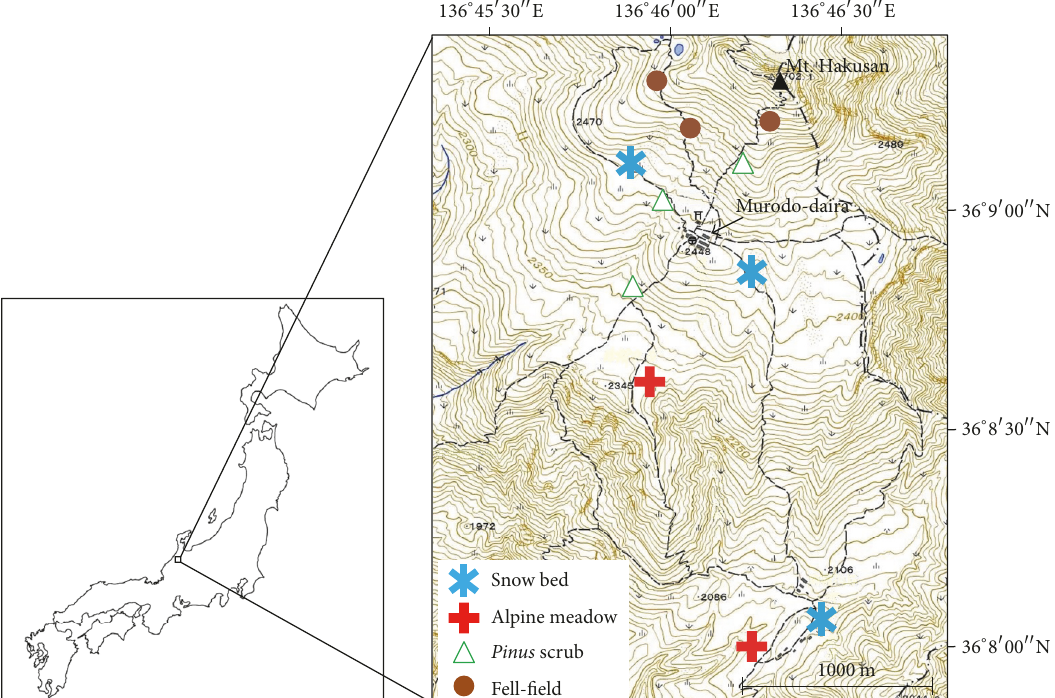
Figure 1: Maps showing the location of the study area and the 11 study sites encompassing four habitats in the alpine-subalpine zone on Mt. Hakusan in central Japan (Geospatial Information Authority scale of 1/50,000; Japan Topographic Map). Murodo-daira indicates the location of the meteorological